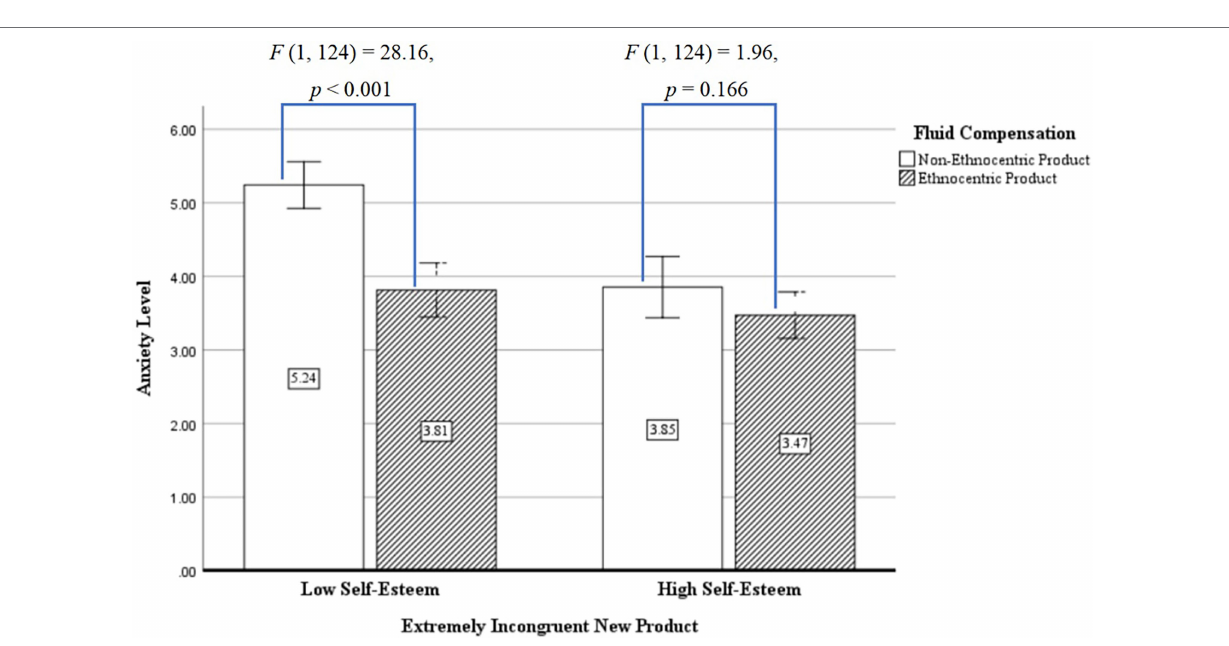
FIGURE 3 | Interactive effects of self-esteem and fluid compensation on anxiety. Error Bar: 95% confidence